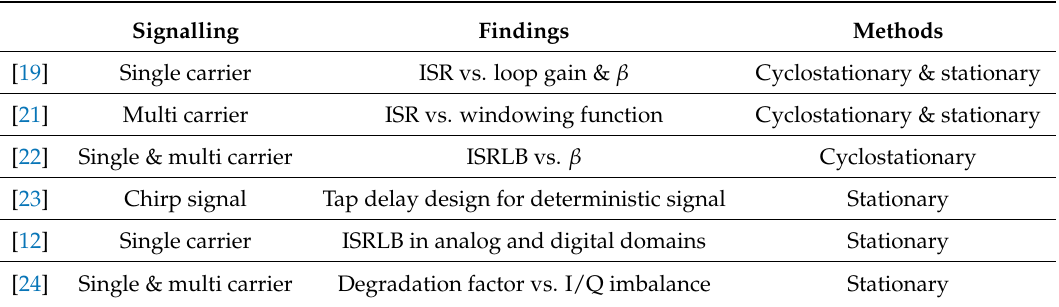
Table 2. Summary of publications on ALMS